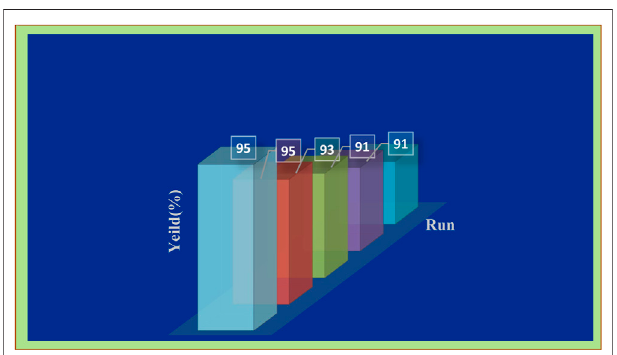
FIGURE7| Thestudyonthecatalystrecyclingactivityinthesynthesisof product 4c .